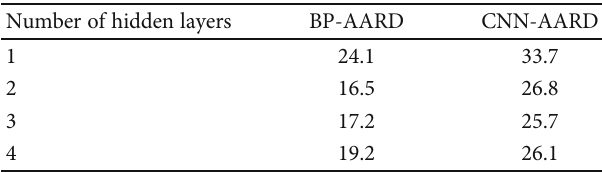
Table 3: Number of hidden layers of di ff erent neural networks.